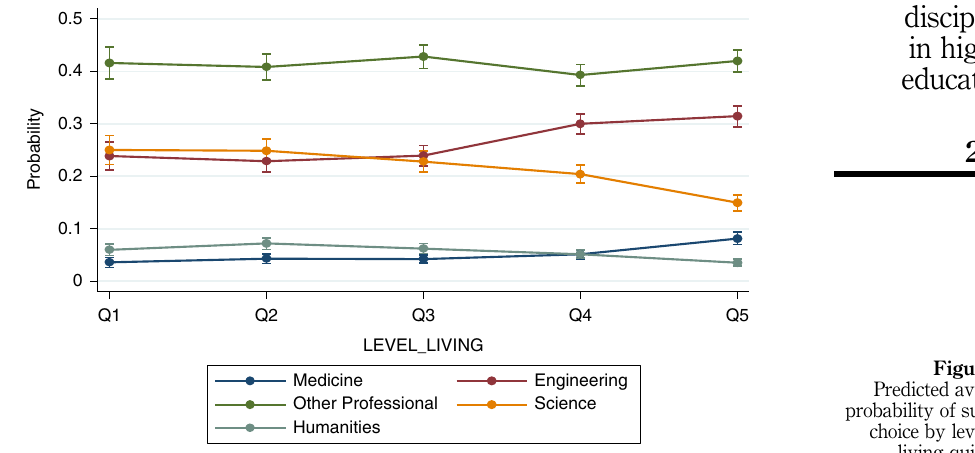
Figure 1. Predicted